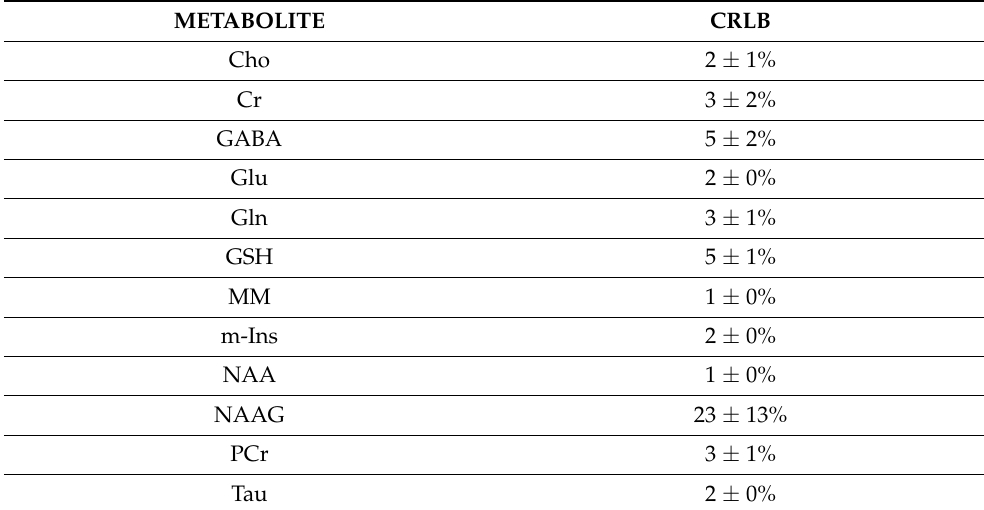
Table 1. Fitted metabolites for which Cramer Rao Lower Bounds fitting errors (CRLB,%) were lower than 25%, as estimated by jMRUI software. METABOLITE CRLB Cho 2 ±